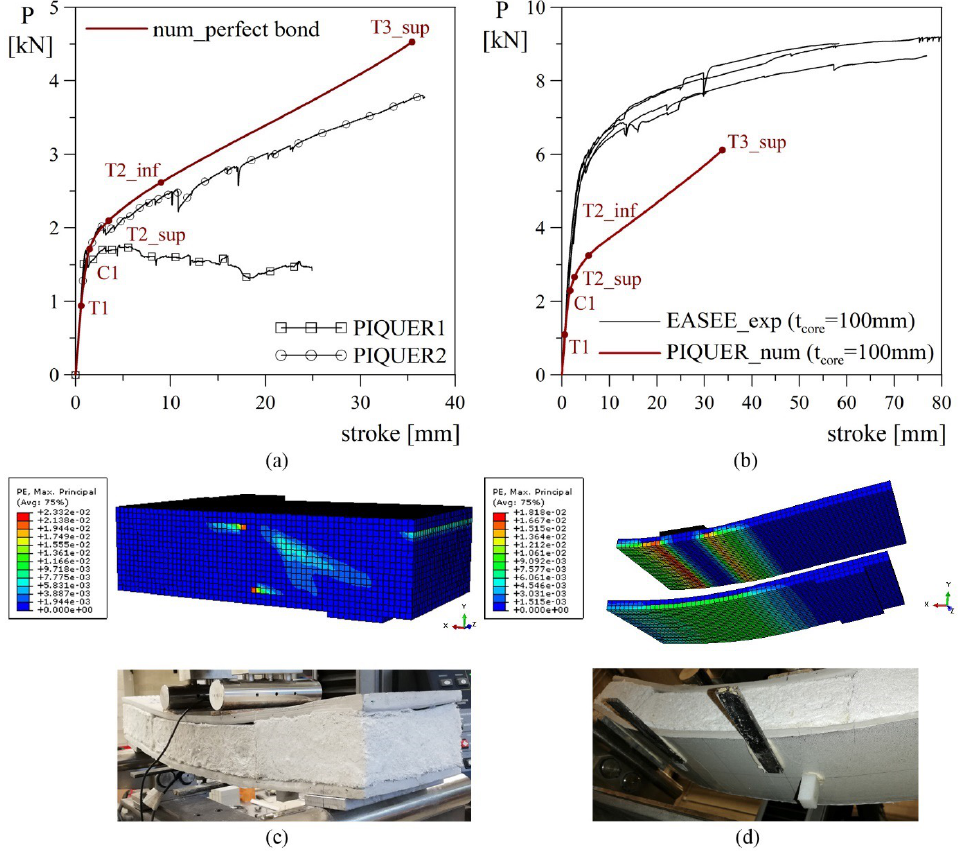
Figure 5. FE model results: numerical response compared with experimental results (a) and with EASEE bending behaviour (b); failure modes for specimen PIQUER2 showing core strut yielding at point C1 (c) and TRC multi- cracking at point T3_sup